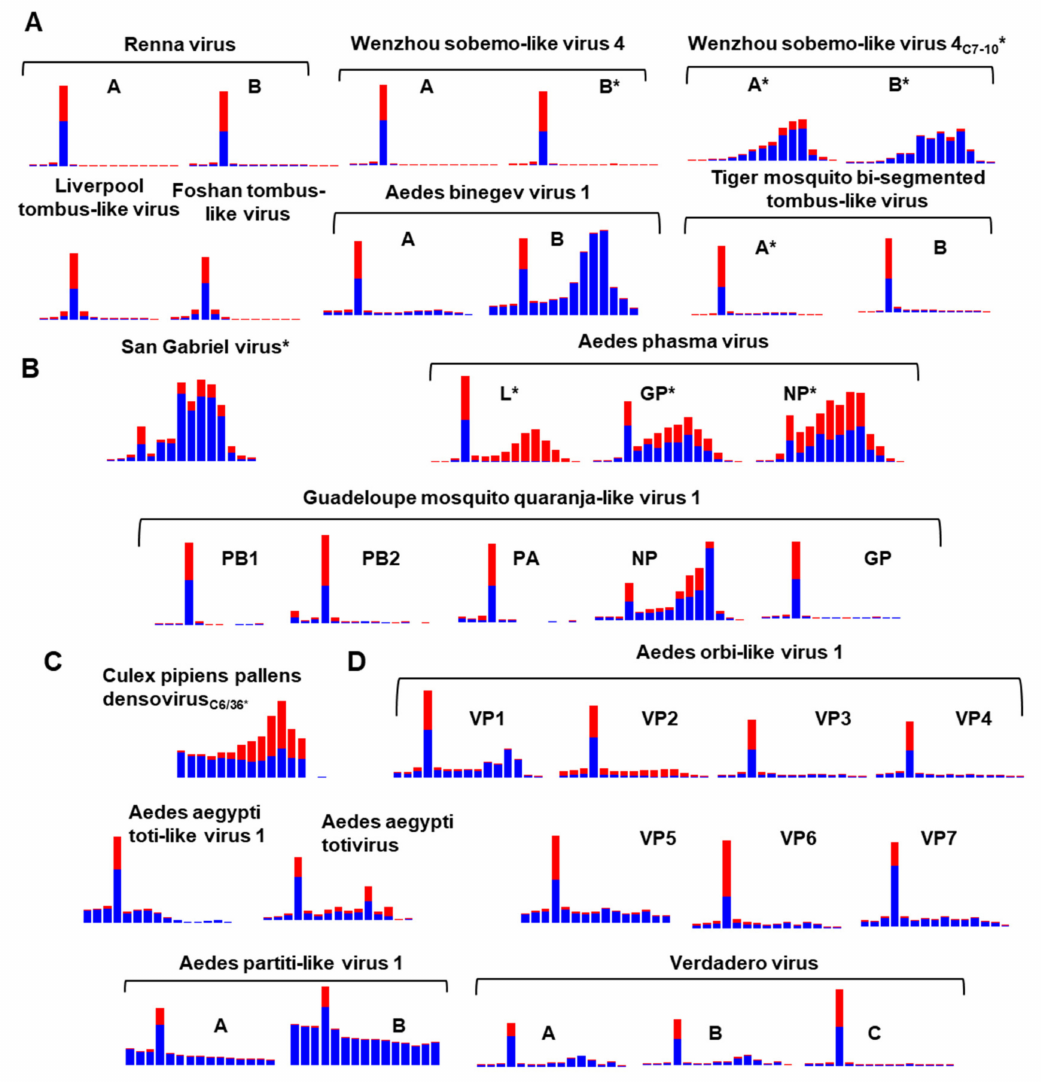
Figure 9. RNAi responses to Aedes viruses. Bar graphs represent extracted small-RNA reads (18–32 nt) mapped to the representative genomes of Aedes viruses presented in this study. Reads originating from the genomic sense are indicated in blue, and anti-genome sense reads are red. Virus segments that have both a characteristic piRNA signature (adenine at position 10, A 10 , for sense RNA; Uridine at position 1, U 1 for antisense RNA), as well as overlapping 10 nt signature, are indicated with an asterisk (*). Viruses grouped by presumed Baltimore classification scheme with ( A ) IV: (+) ssRNA viruses, ( B ) V: ( − ) ssRNA viruses, ( C ) II: ssDNA virus, and ( D ) III: dsRNA